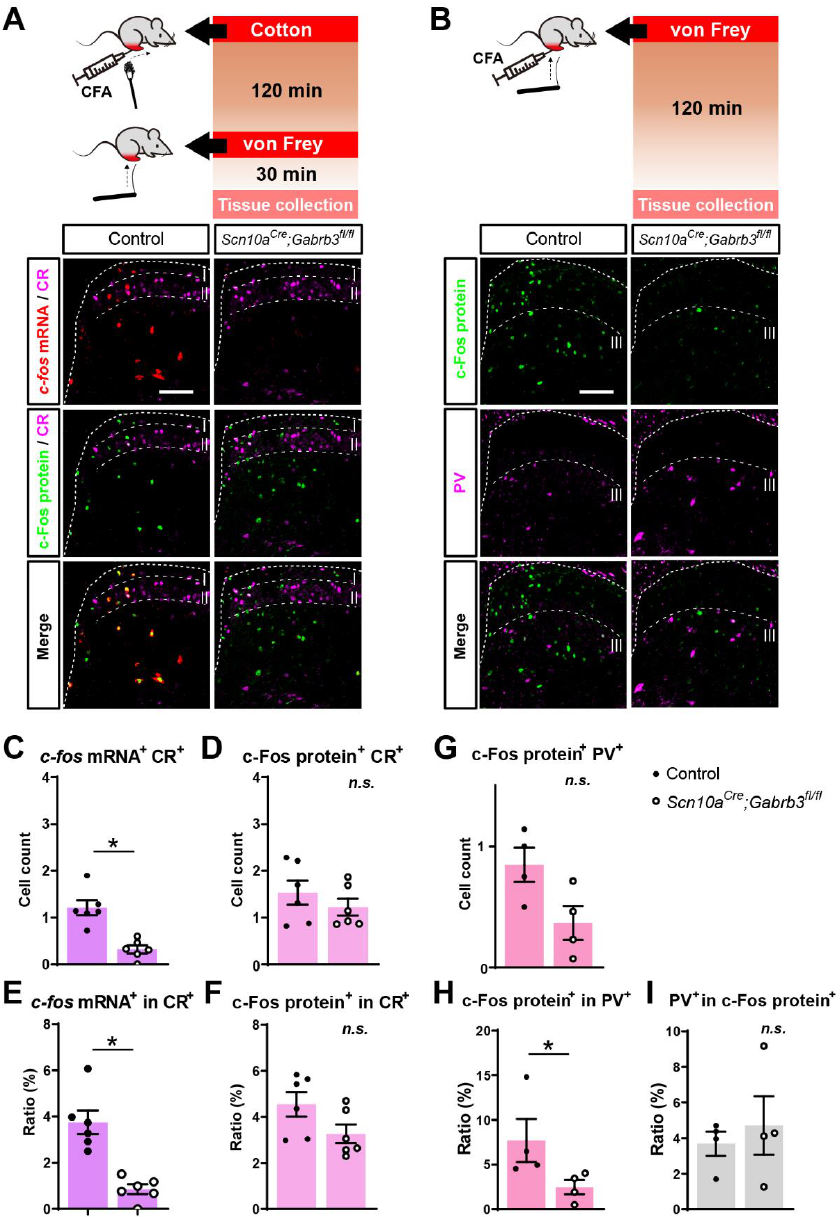
Figure 6. ( A , B ) Co-staining of calretinin-positive (CR, purple, ( A )) and parvalbumin-positive (PV, purple, ( B )) spinal cord neurons with c-fos mRNA (von Frey in schematic, ( A , B )) and c-Fos protein (cotton in schematic, ( A , B ))-positive cells responding to punctate (upper panel, red, ( A , B )) and dynamic (centre panel, green, ( A , B )) mechanical stimulation in control (left, ( A , B )) and Scn10a Cre ; Gabrb3 fl/fl mice (right, ( A , B )). The number of cells labelled with both c-fos and c-Fos (yellow, ( A , B )) are indicated in the lower panel (overlap, ( A , B )). ( C – F ) Counts per slice of cells positive for c-fos mRNA and CR + ( C ) or c-Fos protein and CR + ( D ) in Scn10a Cre ; Gabrb3 fl/fl mice (open markers, ( C – I )) and littermate controls (closed markers, ( C – I )). The percentage of c-fos -positive cells within the CR + population ( c-fos mRNA + in CR + , ( E )) and the percentage of c-Fos-positive cells within the CR population (c-Fos protein + in CR + , ( F )). ( G – I ) Counts per slice of cells positive for c-Fos protein and PV + ( G ). The percentage of c-Fos-positive cells within the PV + population (overlap in PV + , ( H )) and the percentage of PV + cells within the c-Fos population (PV + in c-Fos protein + , ( I )). Data represent averages of 12–15 coronal slices per mouse from lumbar (L3–L5) spinal dorsal horn using 6 Scn10a Cre ; Gabrb3 fl/fl mice and 4 littermate control mice for CR staining and 4 mice per group for PV staining. Values of p < 0.05 were considered significant and are indicated with asterisks as follows; * p < 0.05, n.s. = not